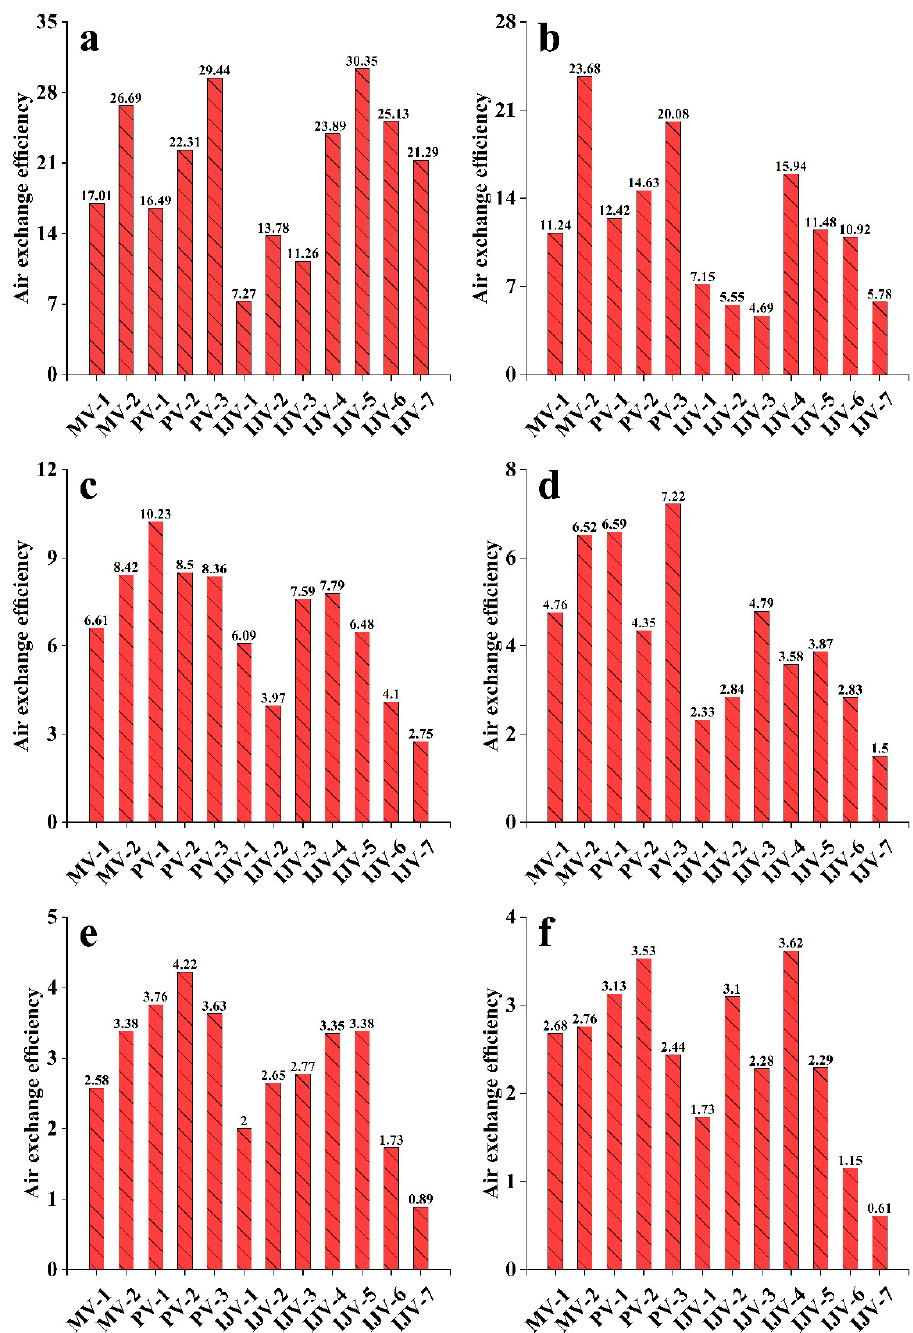
Figure 13. Air exchange efficiency in different scenarios, ( a – f ): ACH = 5–30.